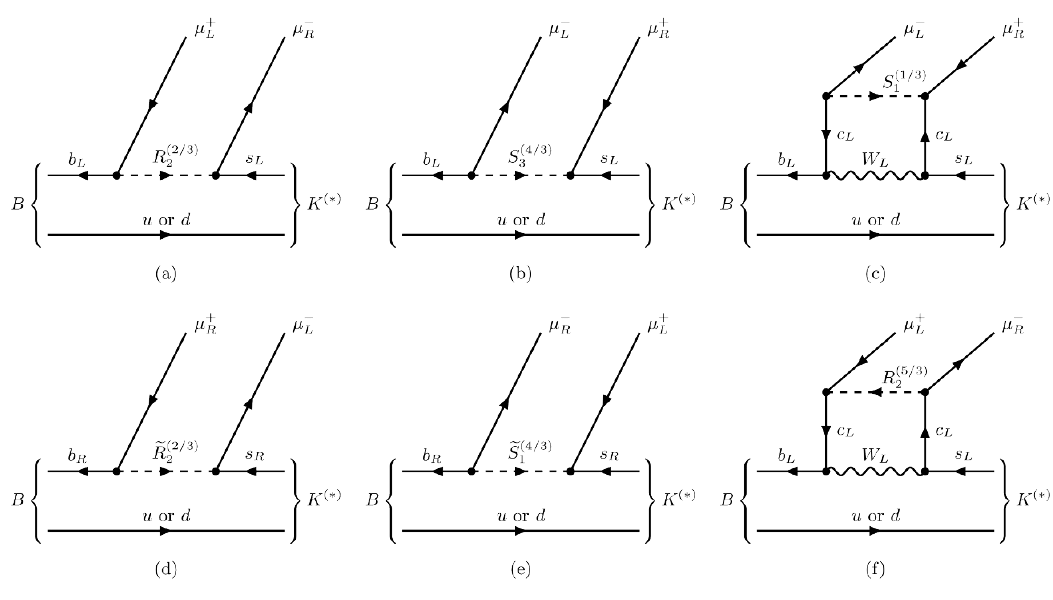
Figure 2 . Possible leptoquark contributions to B ! K ( (cid:3) ) (cid:22) + (cid:22) (cid:0)